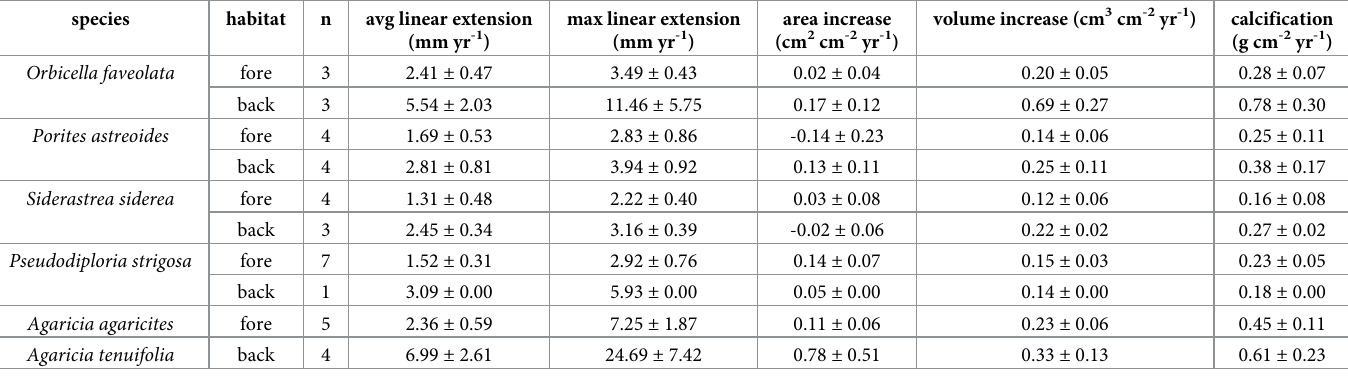
Table 1. Photogrammetry-derived colony-scale growth metrics (average ± SD) for six common Caribbean coral species at a fore reef site (7 m depth) and a back reef site (2 m depth) close to Puerto Morelos, Mexico.